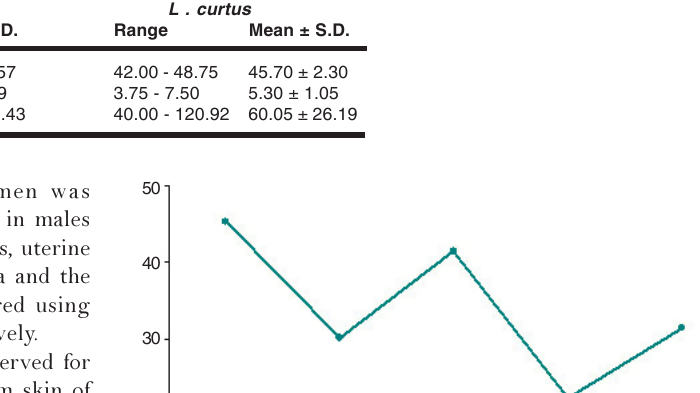
Table 2. Details of morphometric measurements of sea snake specimens (N=43) collected from Goa coast along with their means and standard deviation Morphometric